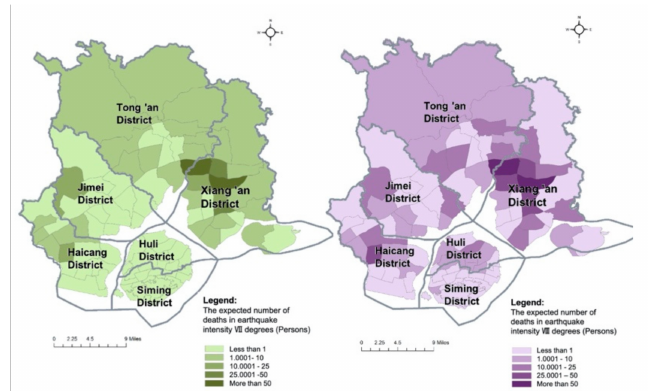
Figure 4. The distributions of the expected number of deaths in earthquake scenarios with intensities of VII degrees and VIII degrees.